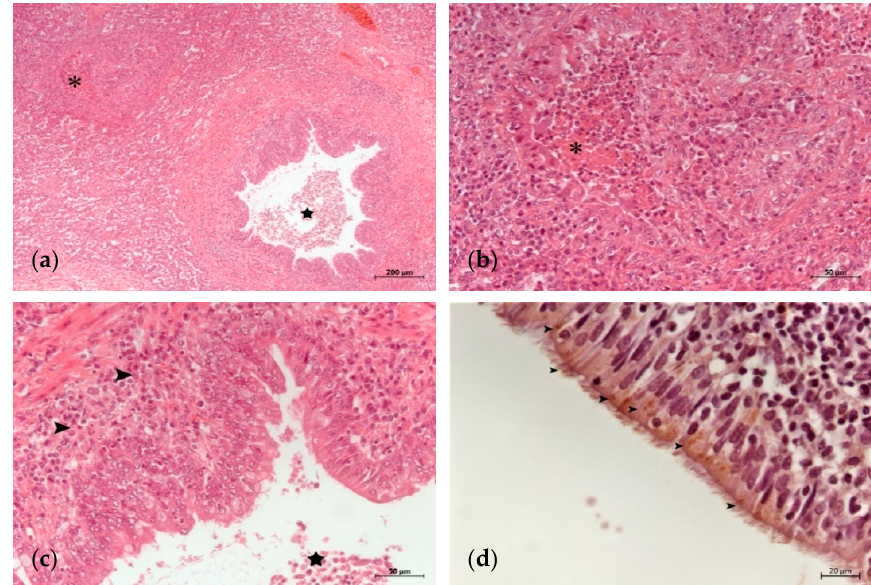
Figure 1. Initial histopathological lung lesions in a calf with M. bovis infection: ( a ) area of suppurative bronchopneumonia with inflammatory infiltrate in the wall and the lumen of a bronchiole (star) and the beginning of a caseonecrotic focus (asterisk) (H-E); ( b ) detail of the caseonecrotic focus of ( a ) associated with neutrophilic exudation (asterisk) (H-E); ( c ) bronchointerstitial lymphoplasmacytic (arrowheads) and neutrophilic (star) inflammatory infiltrate predominate in the bronchiolar wall and lumen, respectively (H-E); ( d ) detail of the bronchiolar epithelial cells showing mononuclear infiltration and M. bovis antigen (arrowheads) (IHC).